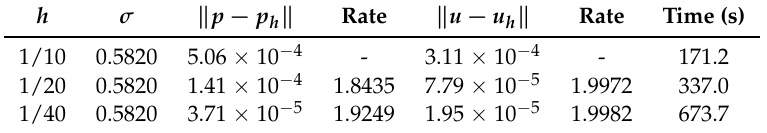
and ∆ t = 1 . 500 500